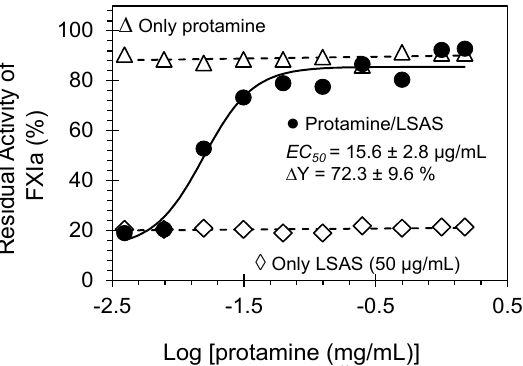
Figure 4. Reversibility of LSAS inhibition of FXIa by protamine sulfate. Shown is the restored FXIa activity (%), which was inhibited by 50 μ g/mL of LSAS, in the presence of ascending concentration of protamine ( ● ). Shown also are the effects of only protamine sulfate (0.0039 mg/mL–1.5 mg/mL) on the activity of FXIa ( Δ ) and the effect of only LSAS (50 μ g/mL) on FXIa. The restored FXIa activity profiles were spectrophotometrically established at and 37 °C and pH 7.4. Solid lines represent fits by the dose–response Equation (2) to get the EC 50 .